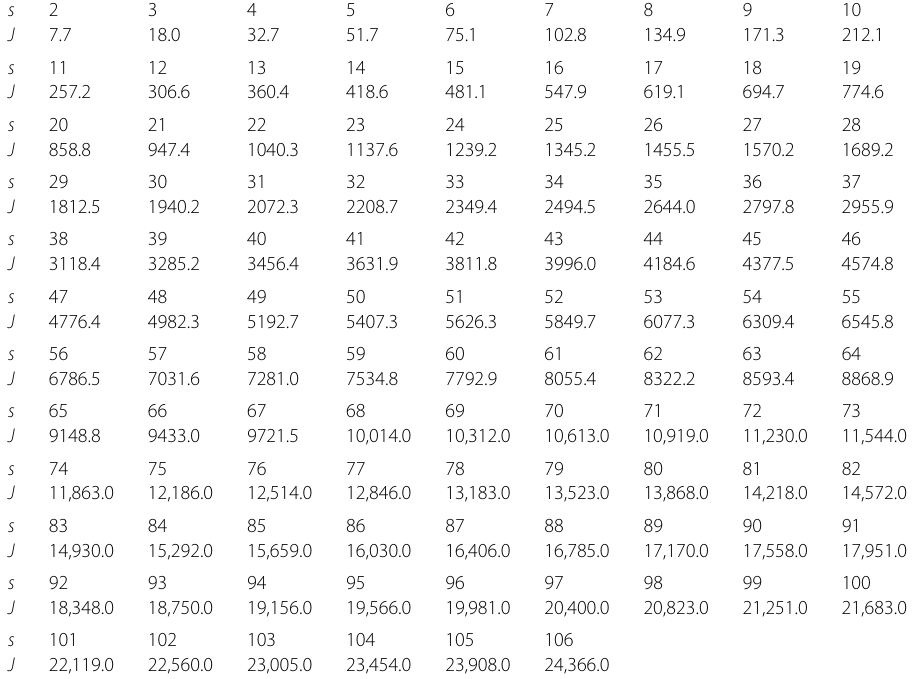
Table 1 The effects of s on J ( u ∗